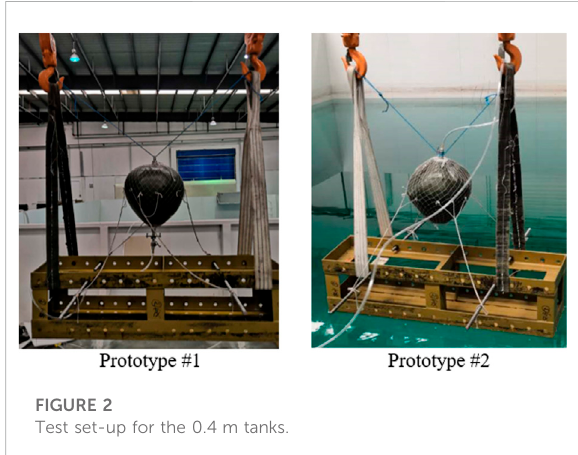
FIGURE 2 Test set-up for the 0.4 m